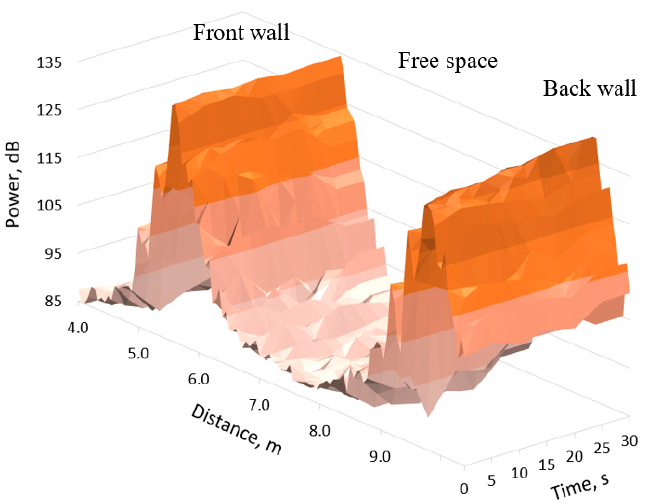
Figure 7. 79 GHz radar signal range profile change over time in steam environment.